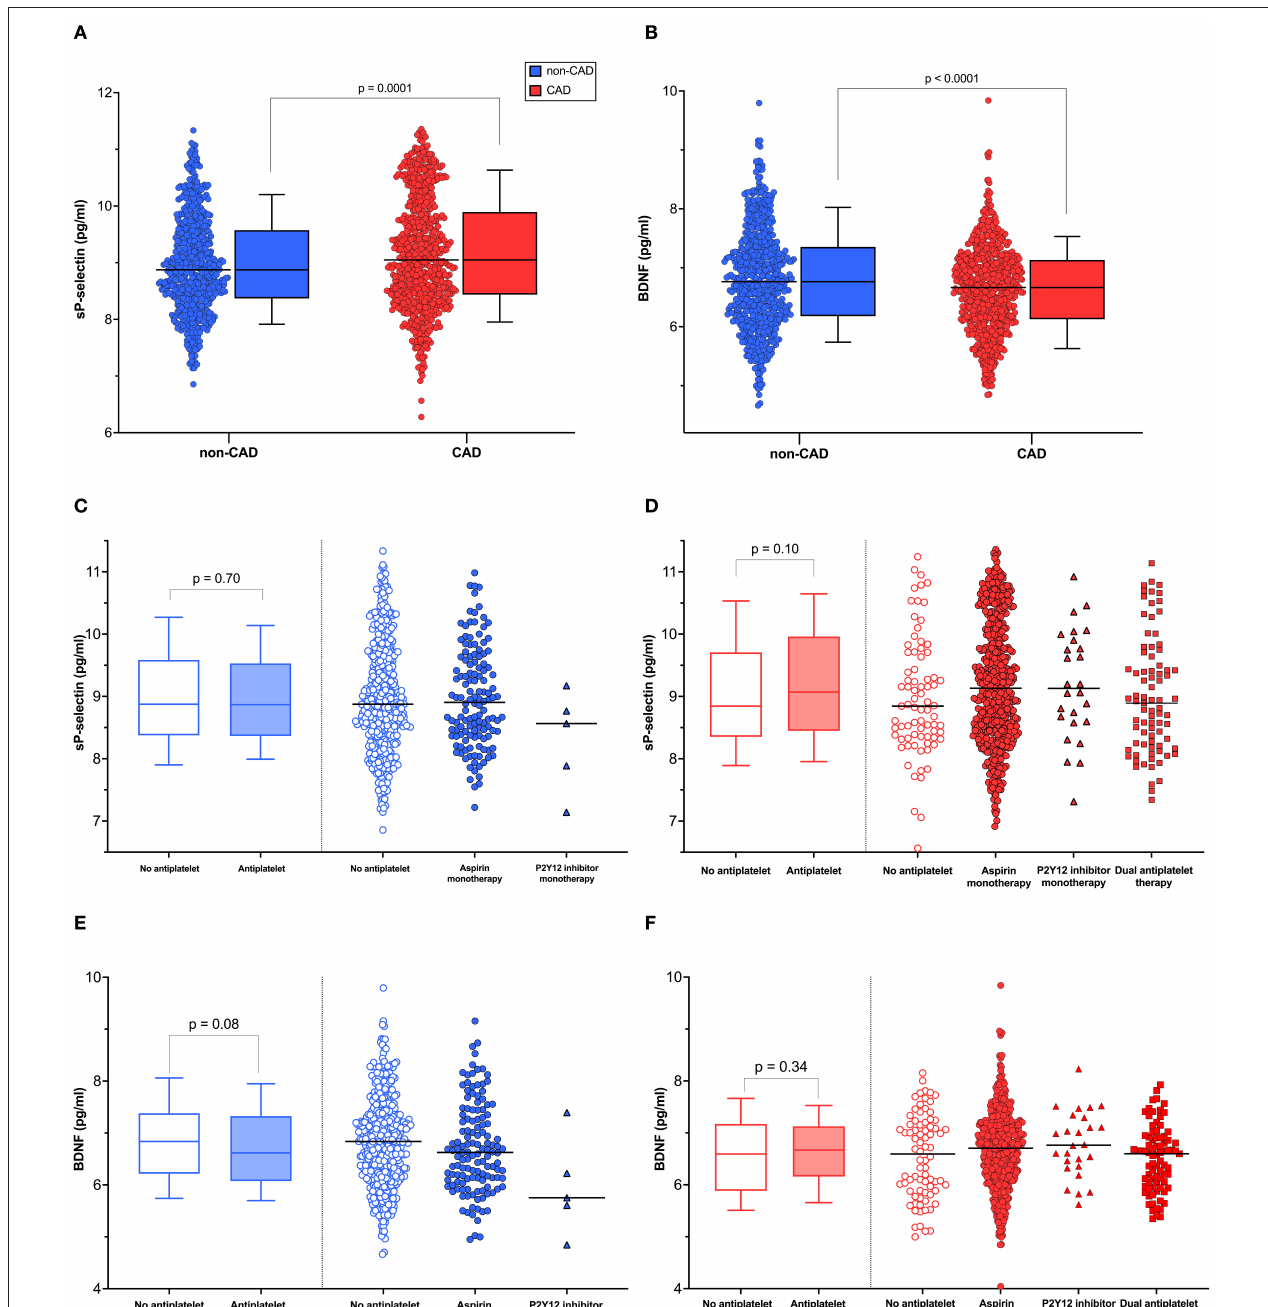
FIGURE 1 | Distribution of sP-selectin levels and BDNF concentrations. (A) sP-selectin and (B) BDNF levels in CAD group ( n = 673) and non-CAD group ( n = 607). (C,D) sP-selectin and (E,F) BDNF levels distributed among users and non-users of antiplatelet therapy. The lines represent the median value; the box marks the 75th and the 25th percentiles; and whiskers indicate the 90th and 10th percentiles. An independent t -test was used to test for significant log-transformed sP-selectin and BDNF levels difference.